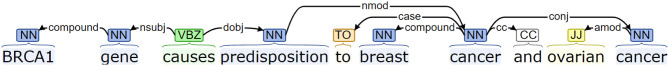
Dependency graph for the sentence “BRCA1 gene causes predisposition to breast cancer and ovarian cancer” generated using Standford coreNLP parser (Manning et al., 2014) (nsubj-nominal subject, dobj-direct object, nmod-nominal modifier, amod-adjectival modifier, conj-conjunction, CC-coordinating conjunction, JJ-adjective, NN-noun).